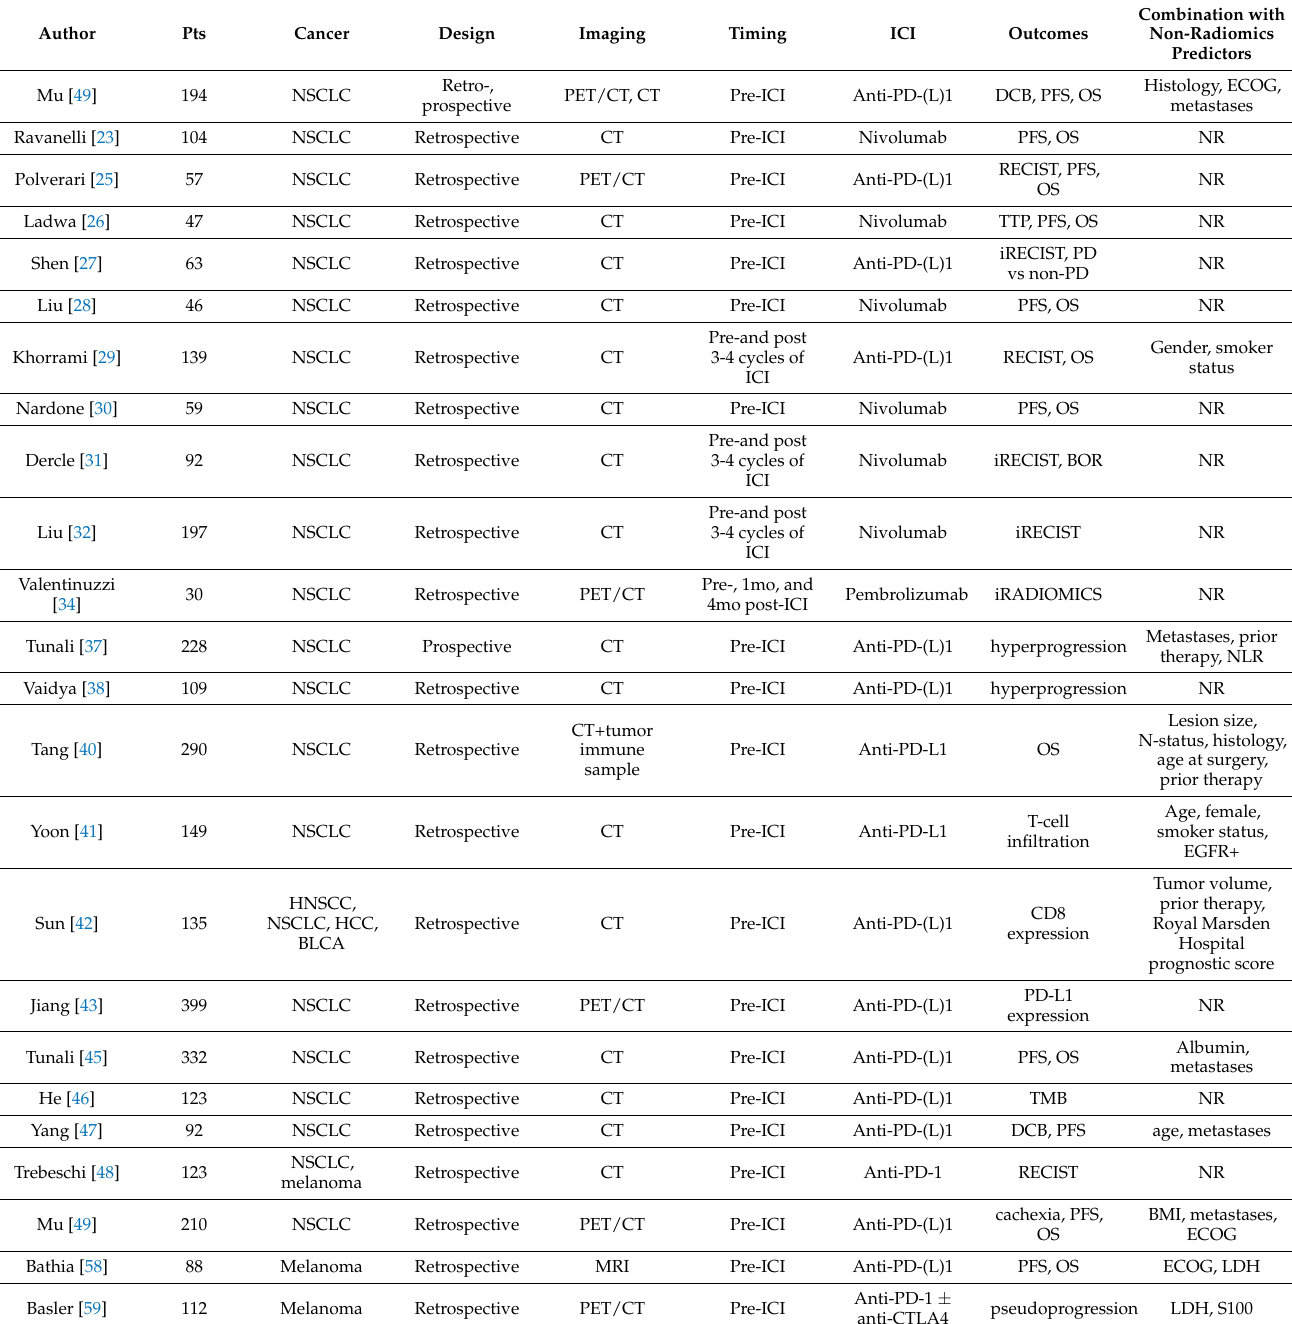
Table 1. Summary of general study